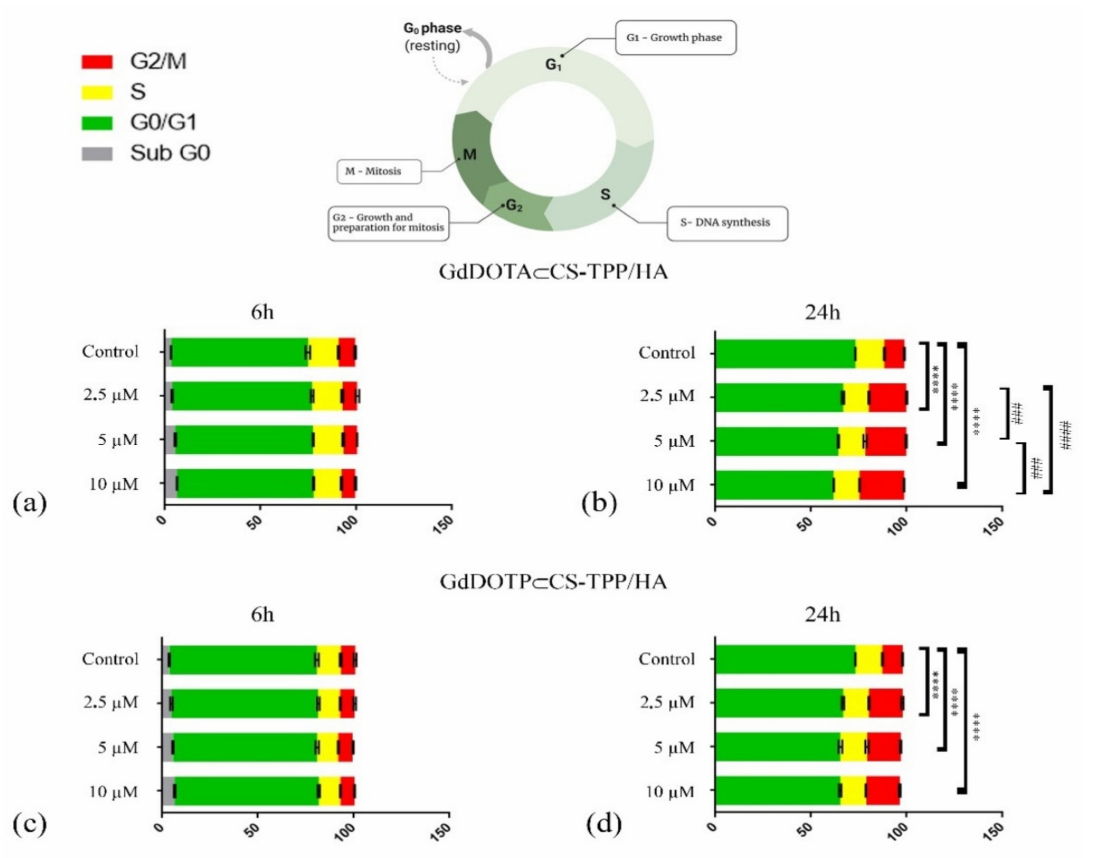
Figure 3. Cell cycle distribution in RAW 267.4 murine macrophage cells treated with ( a ) GdDOTA ⊂ CS-TPP/HA NGs for 6 h; ( b ) GdDOTA ⊂ CS-TPP/HA NGs for 24 h: **** p < 0.0001 control versus 2.5 µ M_G0/G1 and G2/M; control versus 5 µ M_G0/G1 and G2/M and control versus 10 µ M_G0/G1 and G2/M); ### p < 0.001 2.5 µ M versus 5 µ M _G0/G1 and G2/M and 5 µ M versus 10 µ M _G0/G1 and G2/M; #### p < 0.0001 2.5 µ M versus 10 µ M _G0/G1 and G2/M; ( c ) GdDOTP ⊂ CS- TPP/HA NGs for 6 h and ( d ) GdDOTP ⊂ CS-TPP/HA NGs for 24 h: **** p < 0.0001 control versus 2.5 µ M_G0/G1 and G2/M; control versus 5 µ M_G0/G1 and G2/M and control versus 10 µ